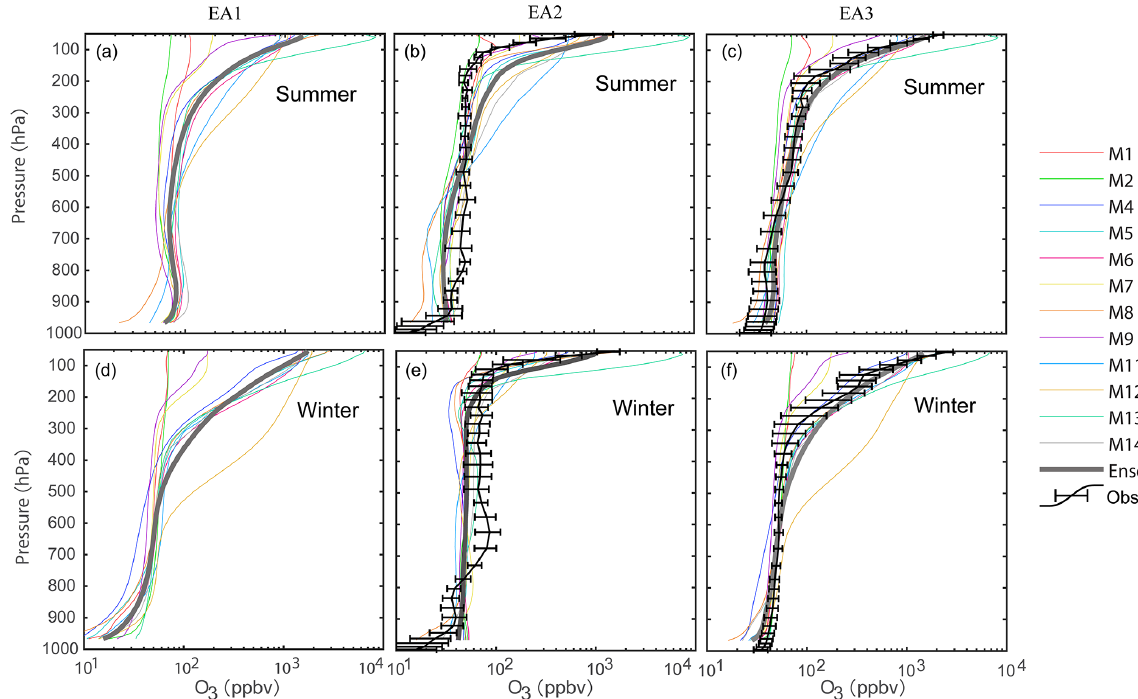
Figure 5. Simulated O 3 profiles for the summer (June–July–August) and winter (December–January–February) of 2010, averaged over all observed stations across three subregions of East Asia: EA1 (a, d ), EA2 (b, e) and EA3: (c, f) . Ozonesonde data for 2010 were taken from the World Ozone and Ultraviolet Radiation Data Centre (WOUDC)